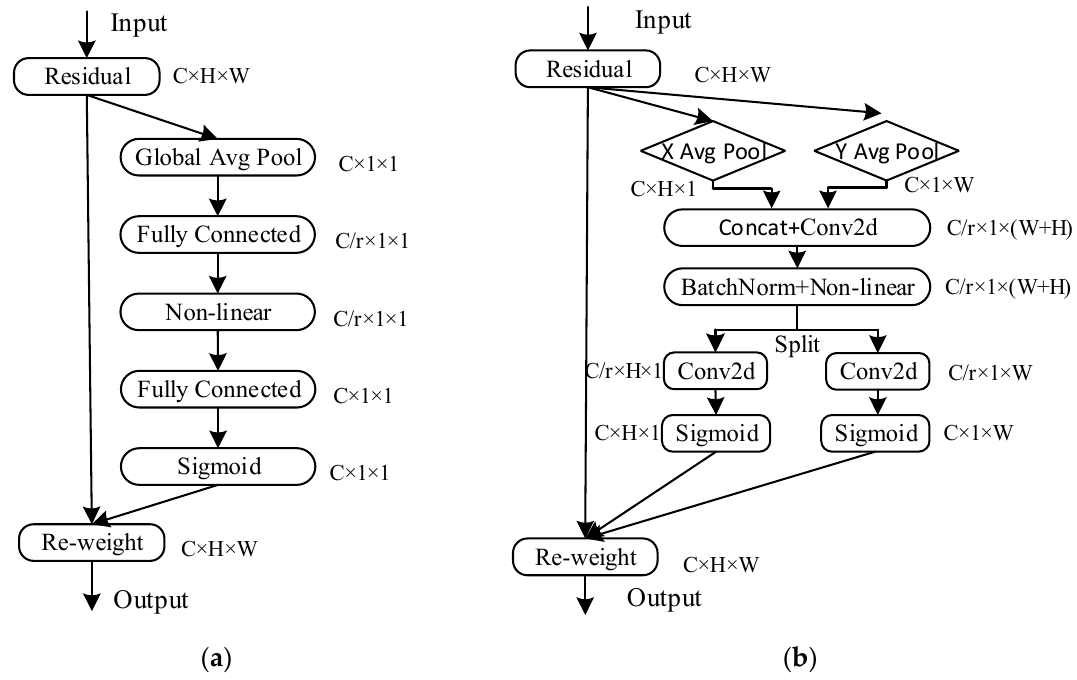
Figure 5. Di ff erent a tt ention mechanism module structures: ( a ) SE a tt ention module structure; and ( b ) CA a tt ention module structure. ( b ) CA attention module